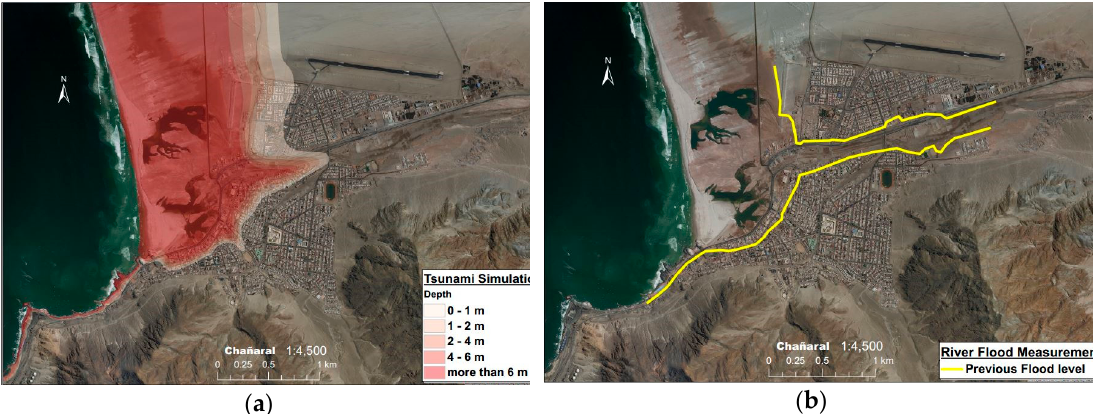
Figure 13. ( a ) Tsunami Inundation map [44]. ( b ) Maximum extent of the river flooding according to post-disaster surveys.